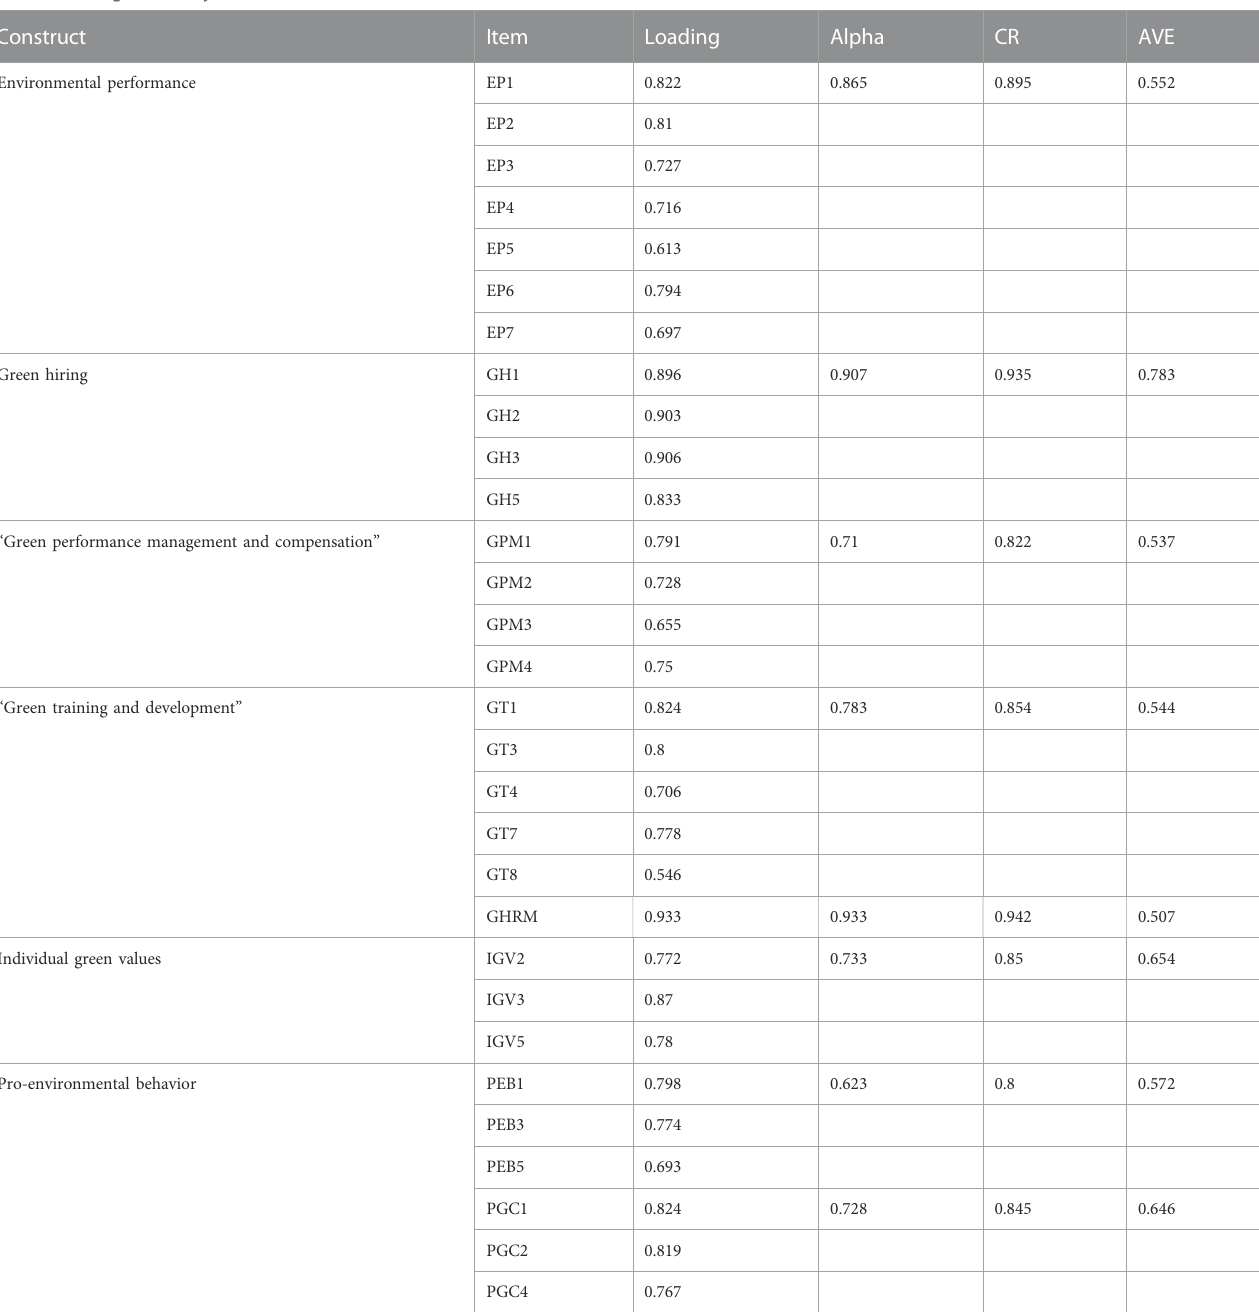
TABLE 1 Convergent validity.